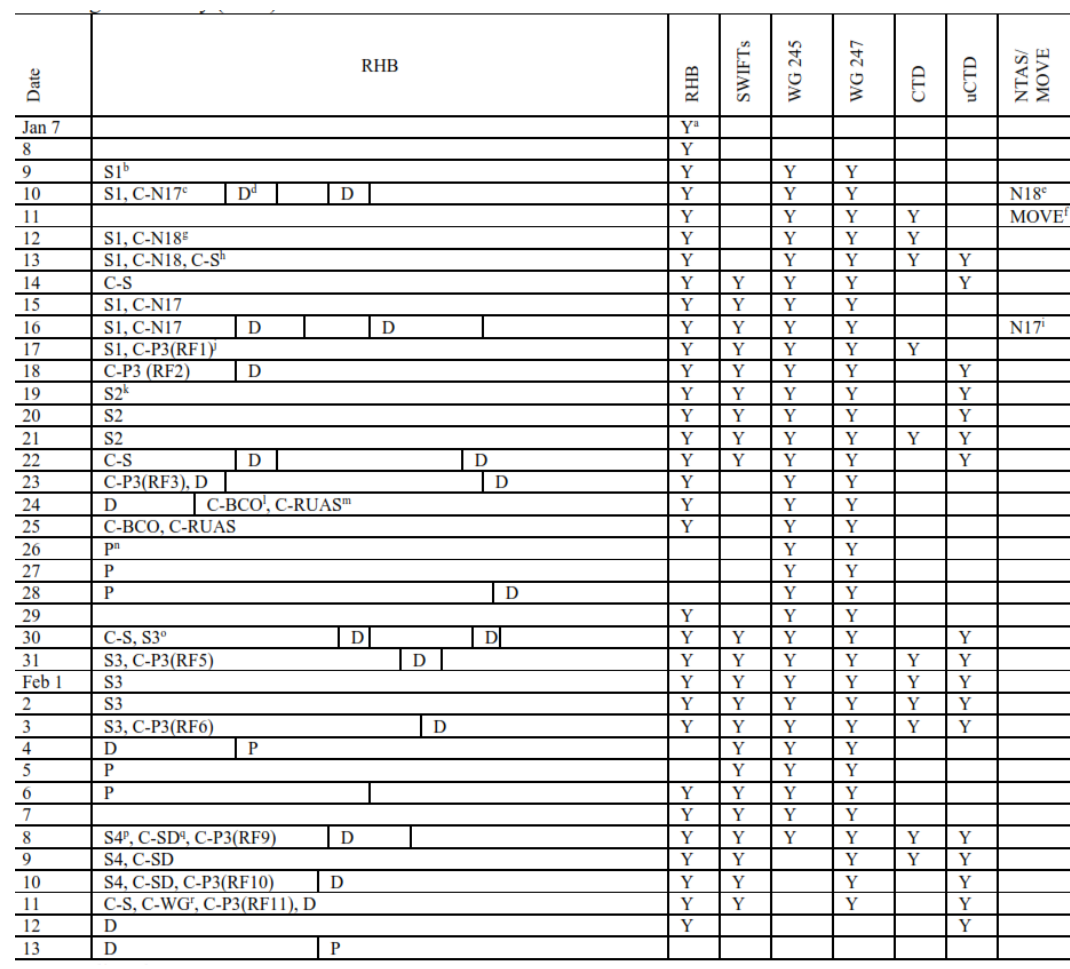
Table 1. Timeline of sampling events on board the RV Ronald H. Brown ( RHB ) including coordination with other platforms, NTAS opera- tions, downwind transits, and periods at each station. The different symbols shown under RHB correspond to the sampling status of the ship and coordination with other assets with spacing of vertical bars indicating time of day